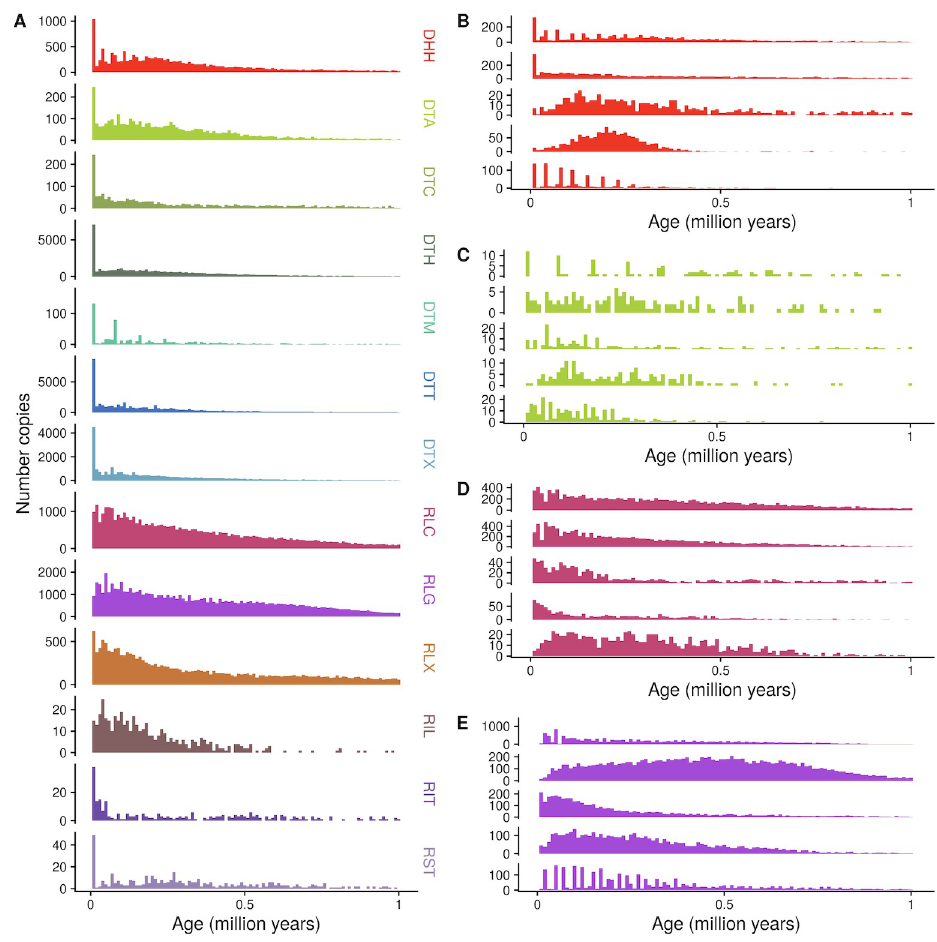
Fig 4. Age distribution of (A) superfamilies and (B-E) five largest families of (B) DHH, (C) DTA, (D) RLC, and (E) RLG. Family names are listed in S1 Table. Counts of number of insertions in 10,000 year bins are shown. As they are rare, TE copies older than 1.1 million years are not shown. Ages are calculated with terminal branch lengths for all TEs except LTR retrotransposons, which are calculated with LTR-LTR divergence. See S5 Fig for LTR retrotransposon plots with terminal branch length